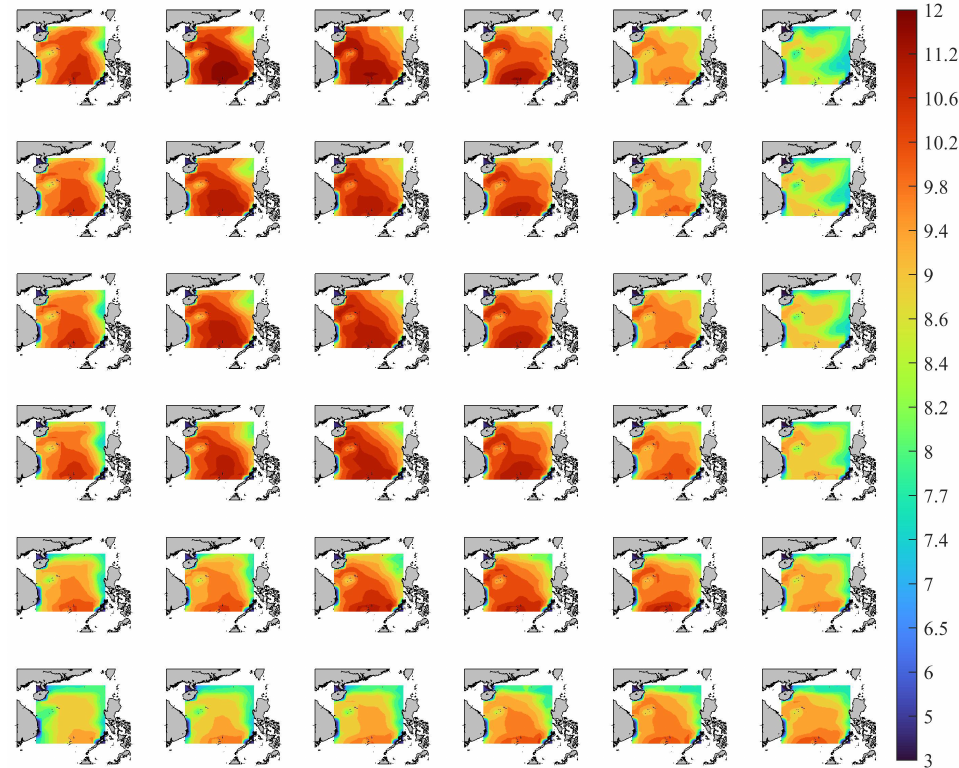
Figure 10. Comparison the forecasting and observation with the MWP field data, in which the results from top to bottom correspond to the observation and the forecasting with 1, 3, 6, 12, and 24-h lead times, and from left to right are the moments every 12-h from 2100UPC on 31 October 2018. The X-axis and Y-axis respectively represent the latitude and longitude of the study